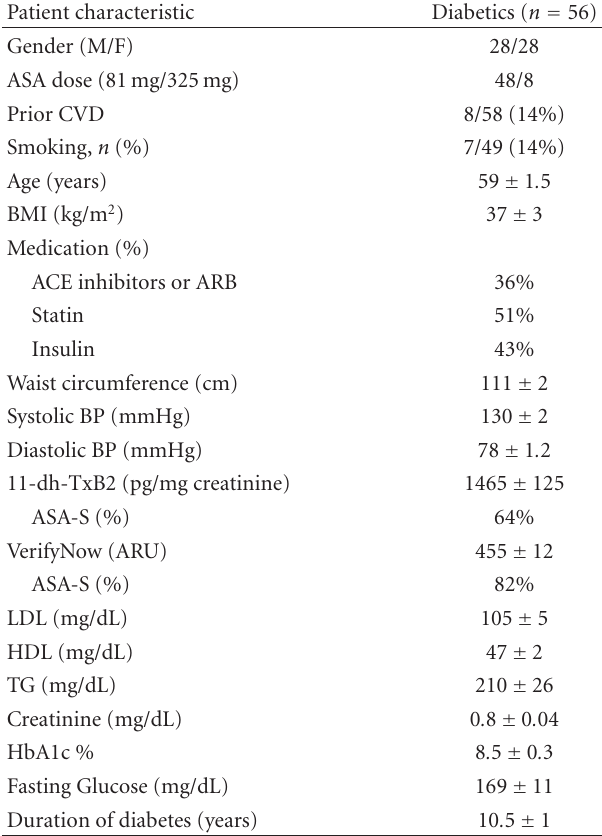
Table 1: Baseline